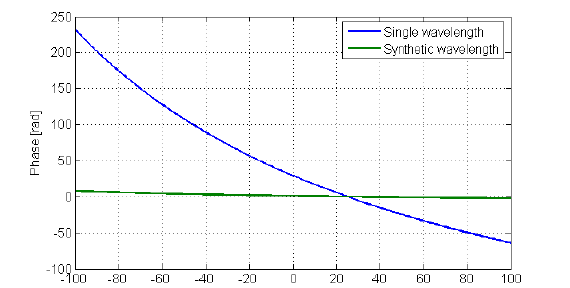
Fig. 6. Dependence of phase change on temperature change. As the temperature varies from its initial value T0=25°C the phase of the object wave changes. Phase ambiguity range [- π , π ] in case of single wavelength is reached for small temperature change while the synthetic phase allows for much larger temperature